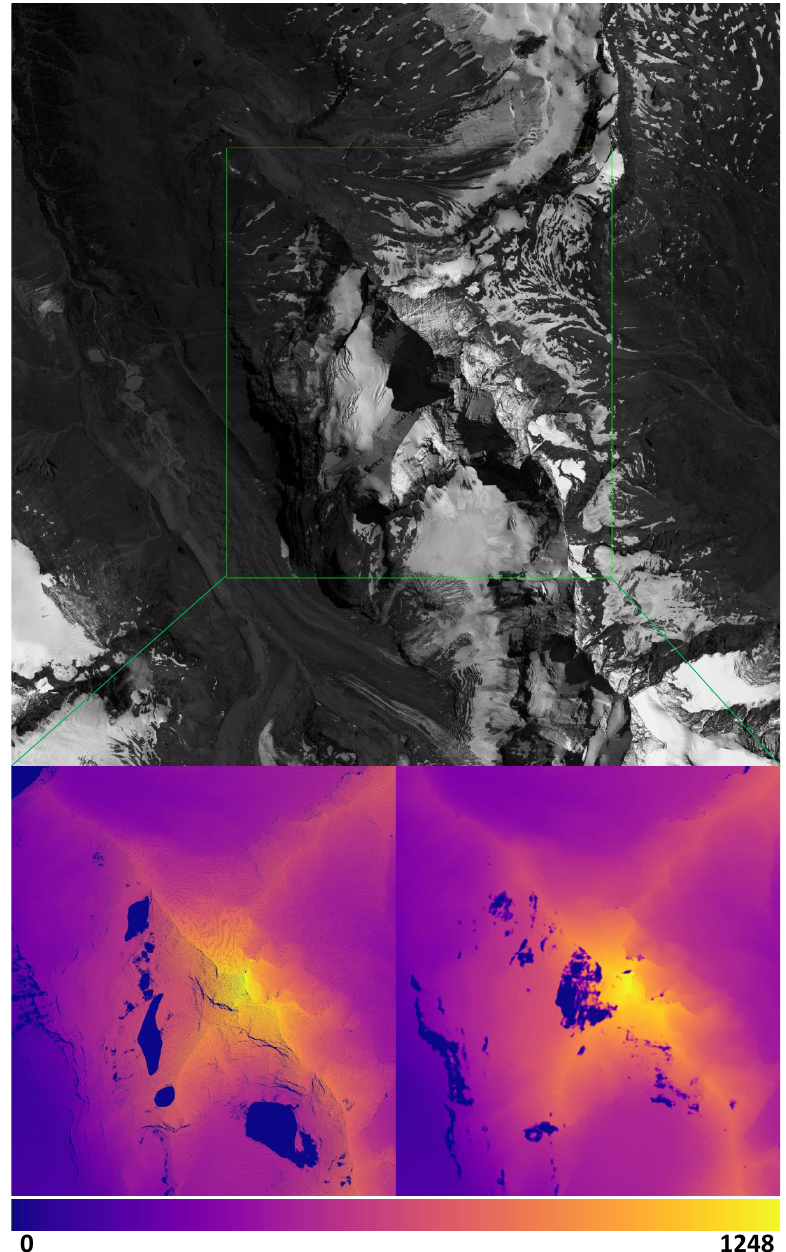
Figure 7. A showcase to indicate the ability of our pyramid network in processing remote sensing stereo pair with large baseline. The test image and the corresponding stereo reconstruction from the reference disparity map ( lower left ) and our pyramid model ( lower right ) are shown. The reconstructed region is highlighted by the green rectangle with a size of 19,791 × 15,639 pixels. Test region: Matterhorn mountain, Switzerland. Test model: